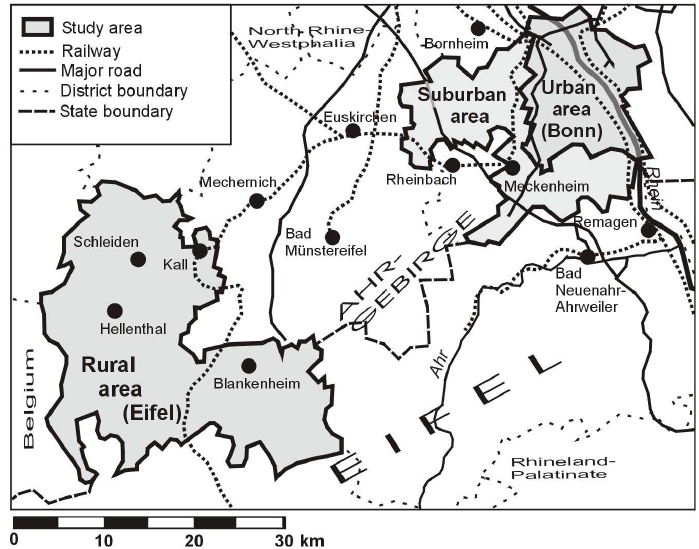
Figure 2: The study areas Design: